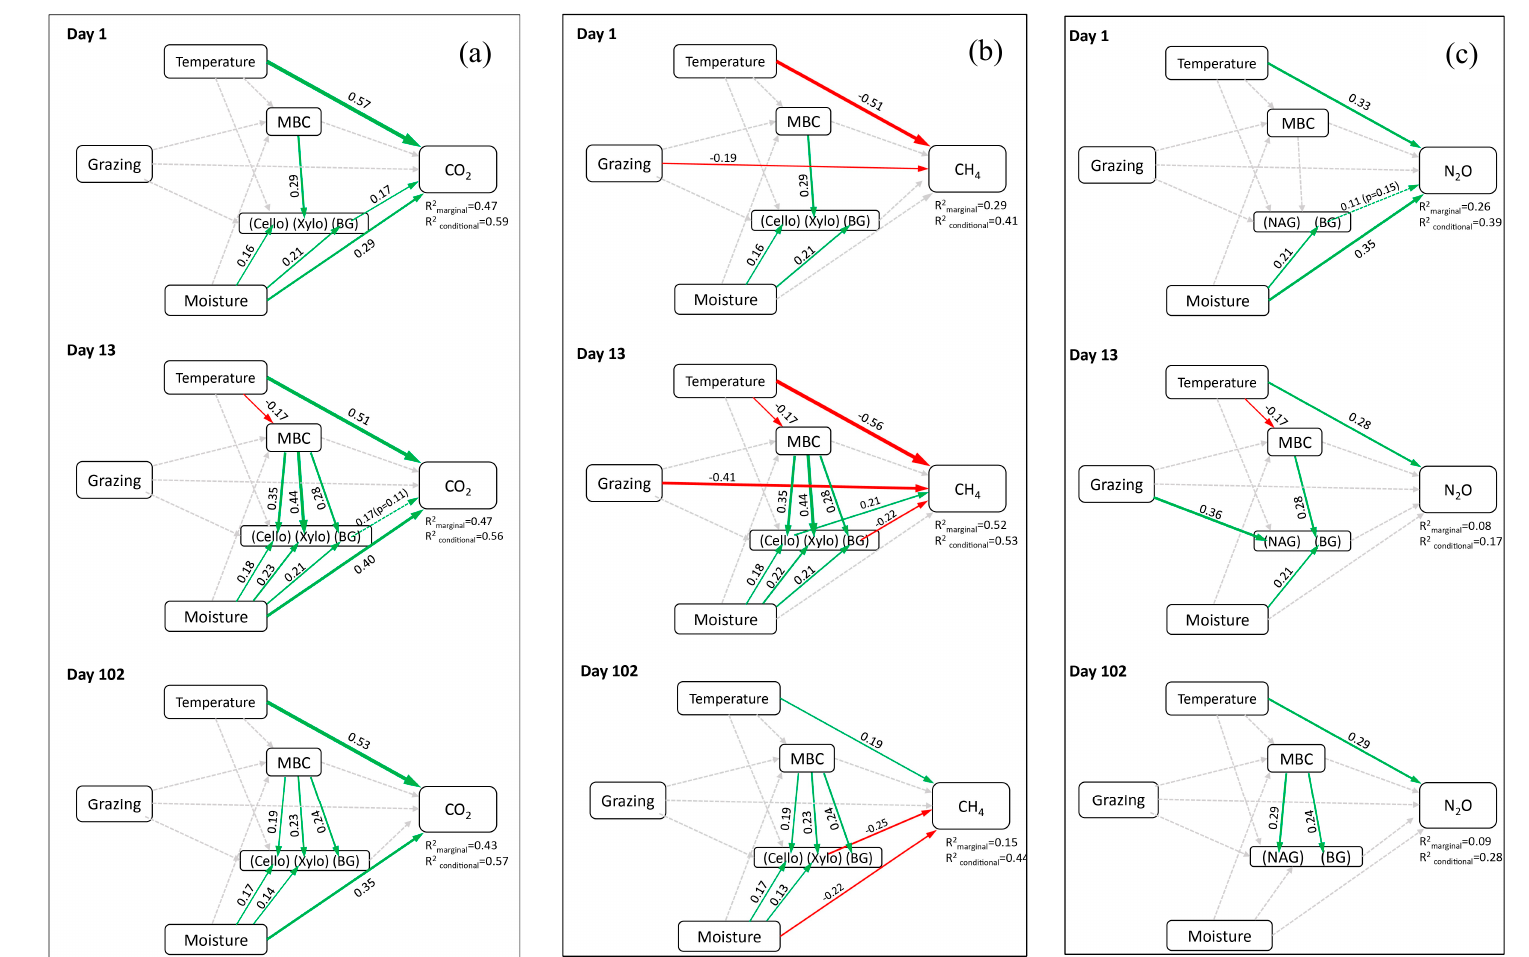
Figure 3. Structural equation models showing relationships between temperature, moisture, soil microbial properties, various extracellular enzyme activities, and fluxes of greenhouse gases ( a ) CO 2, ( b ) CH 4 and ( c ) N 2 O on either day 1 (top row), day 13 (middle row) and day 102 (bottom row) of the soil incubation. The green arrows depict a positive relationship, while red arrows depict a negative relationship on the response variable. Different thickness of arrows indicates the relative strength of the relationship between variables. Refer to text for enzyme names abbreviated in the figures.